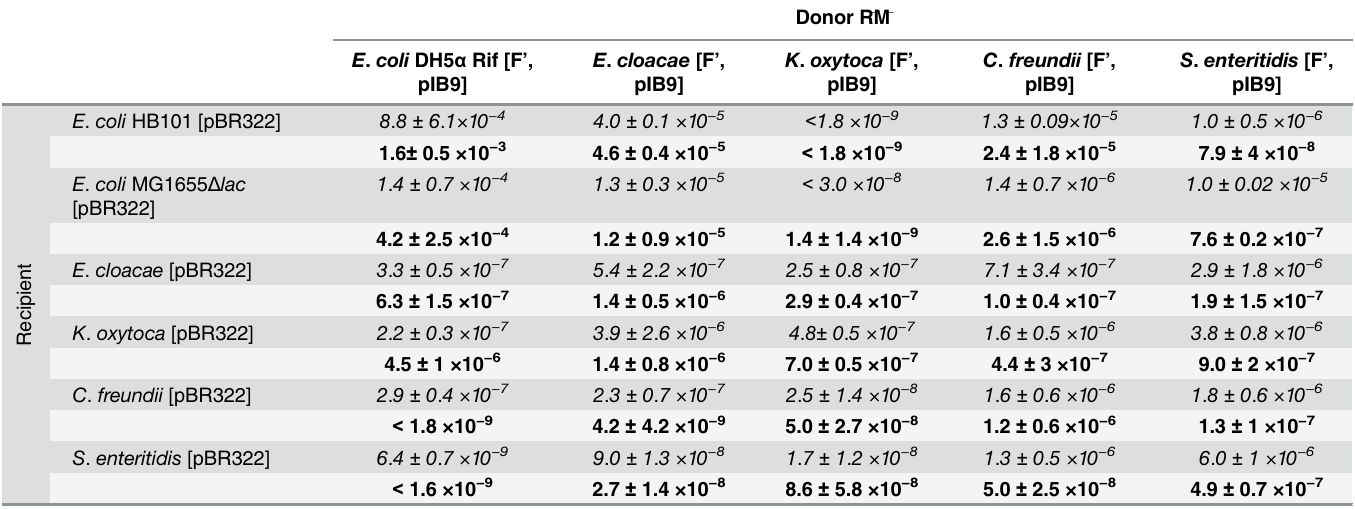
Table 3. Mobilization frequency (italics) of pEC156-derivative pIB9 (EcoVIII R (cid:1) M (cid:1)